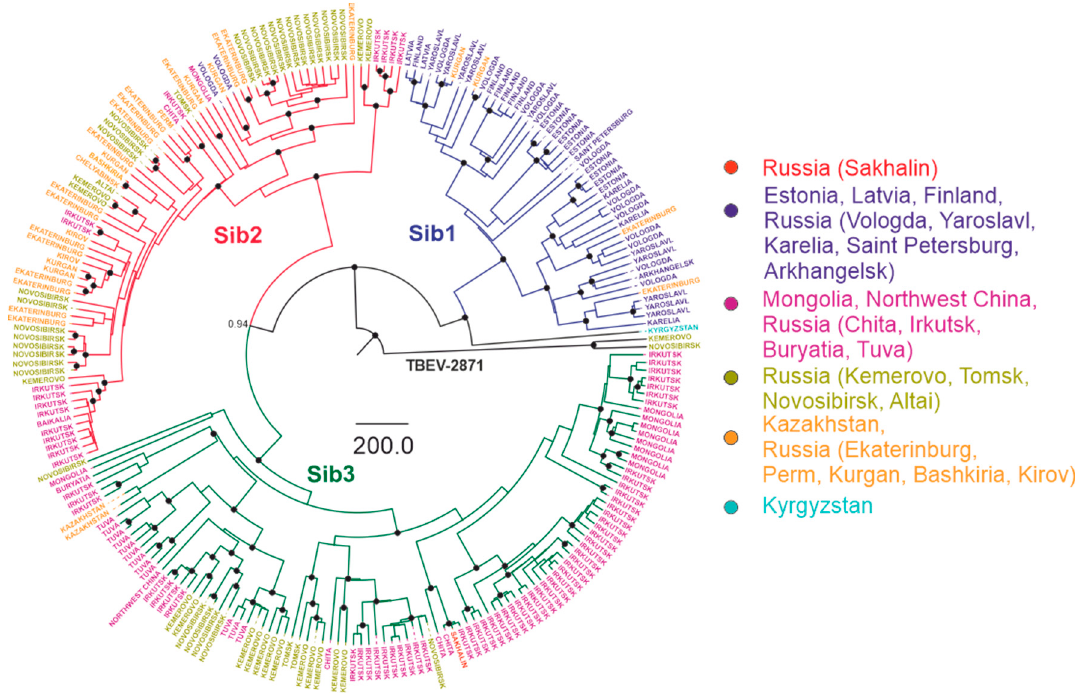
Figure 6. Bayesian phylogenetic analysis of near-complete E-gene sequences of Siberian TBEV. Branches are color-shaded according to described groups. Tree tips are named according to region of isolation. Countries or country regions of virus sampling were grouped into six color-coded geographical regions. Node posterior probabilities above 95% are shown by black circles at the relevant nodes.